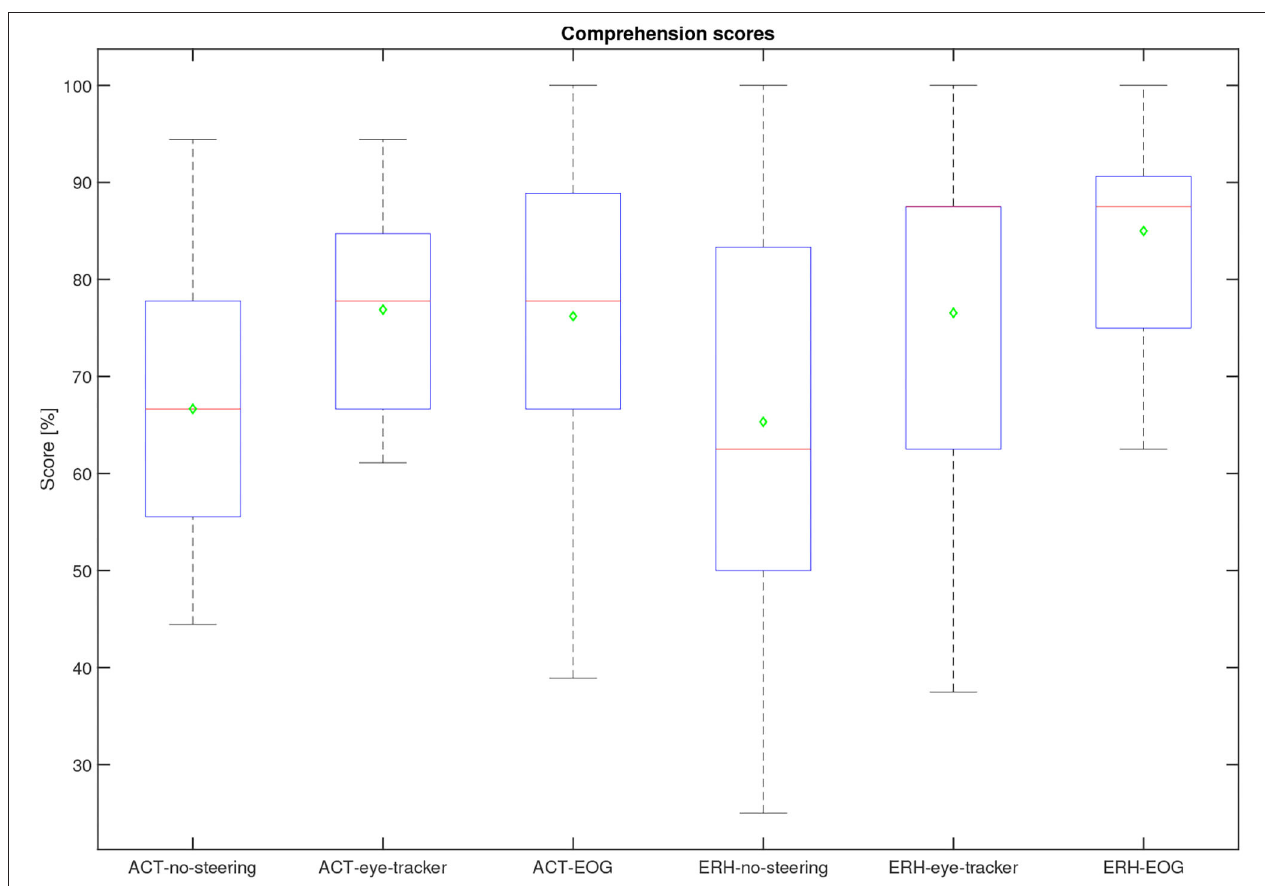
FIGURE 11 | Comprehension performance scores for all participants per condition. The median is the red line, the mean is a green diamond, the box represents the 25 and 75 th percentile, the whiskers extend to the extreme values, and the red crosses represent individual